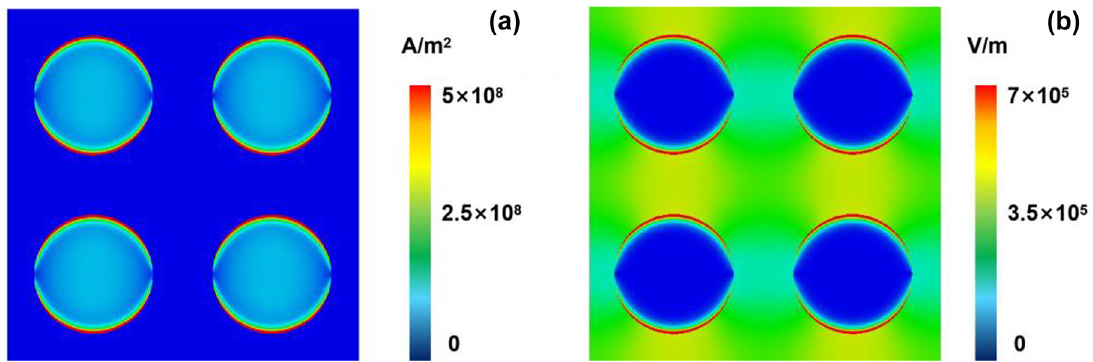
Figure 5: Current density direction on the surface of microdisk array. (a) Top and (b) front views.